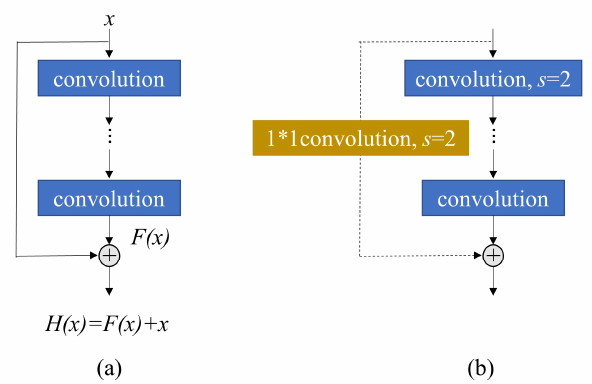
Figure 1. The residual unit structure. ( a ) The basic residual unit; ( b ) the downsampled residual unit.